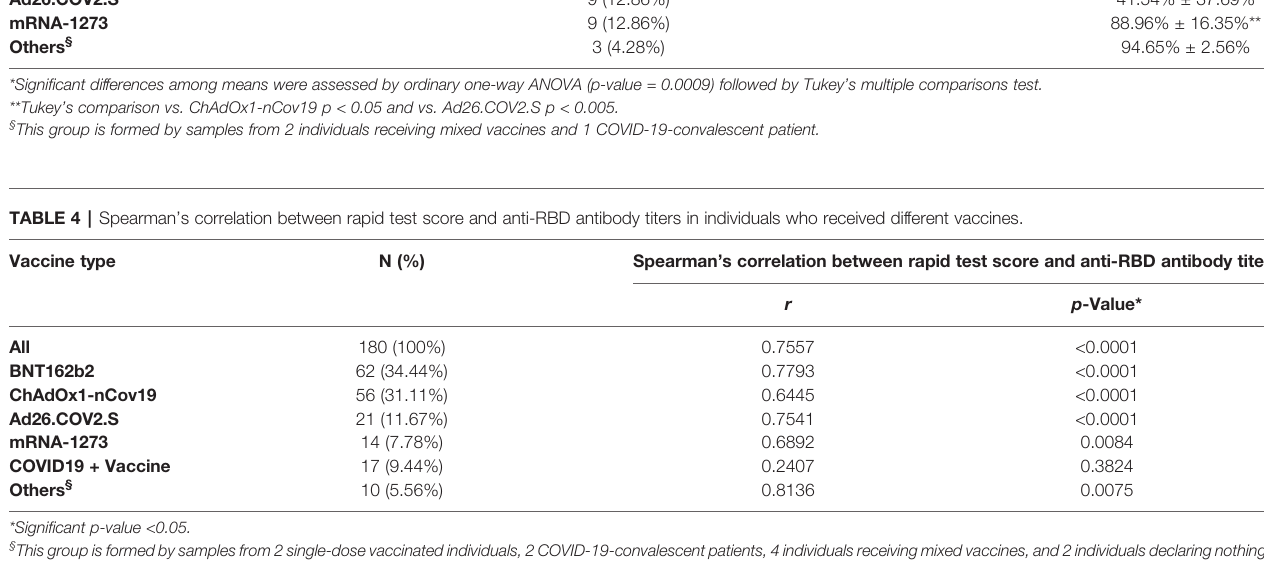
TABLE 3 | Mean neutralizing activity measured by the cPass ™ ELISA-based assay in sera from 70 individuals who received different vaccines. Vaccine type N (%) Neutralizing activity* All